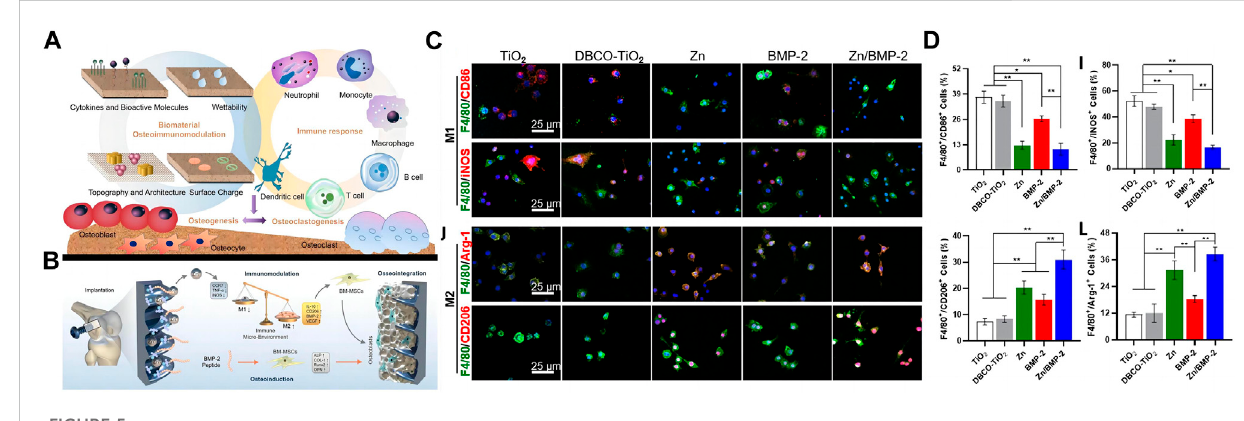
FIGURE 5 Immune cascade after bone implant material. (A) The interaction of biomaterials, skeletal cells, and immune cells, the graph was reprinted with permission from (Xie et al., 2020). (B – D) Zn 2+ and BMP-2 peptide-modi fi ed titanium screws promote macrophage M2 polarization and synergize with BMP-2 to promote bone formation. The graph was reprinted with permission from (Wang et al.,